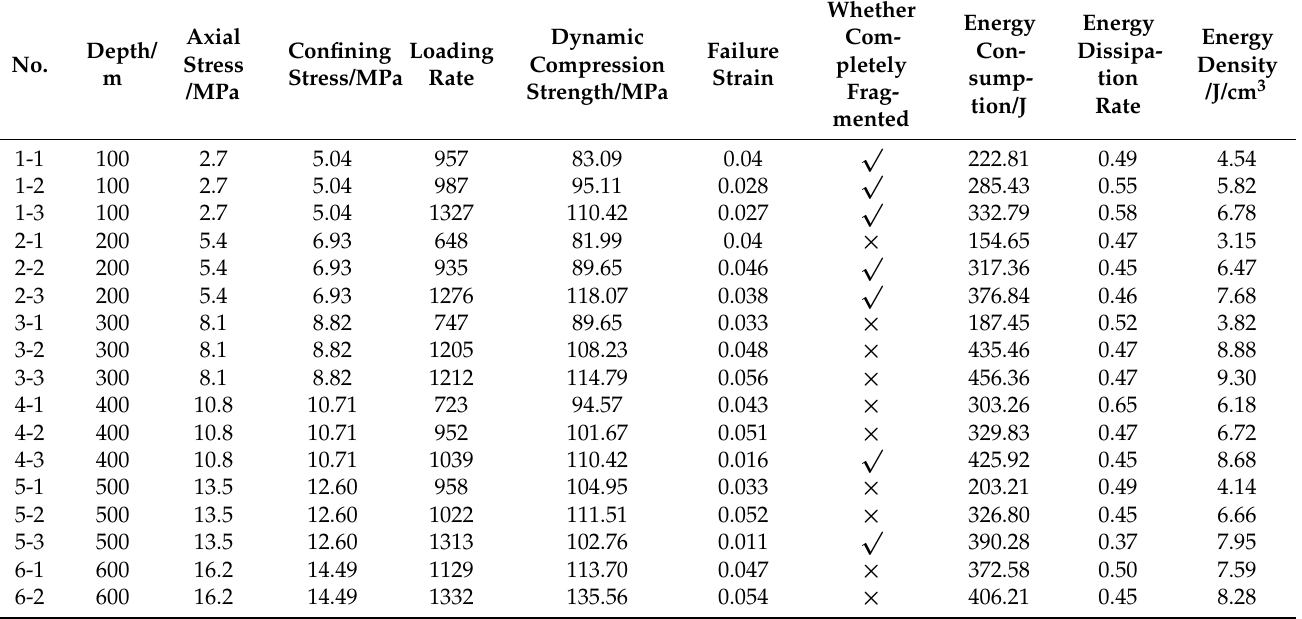
Table 2. Experimental scheme and test